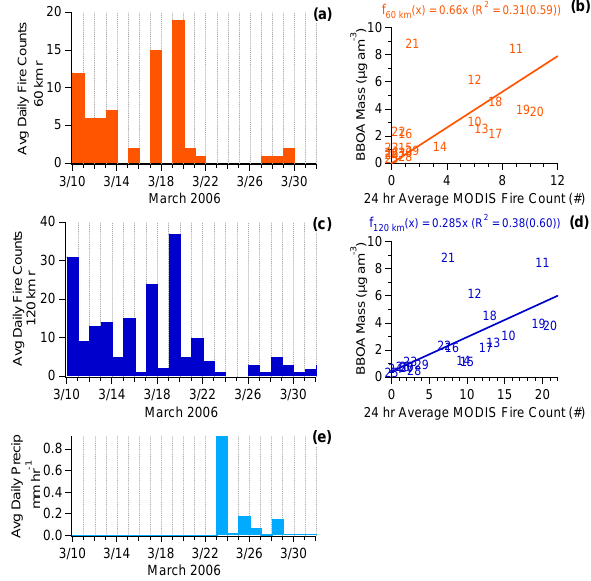
Figure 1. MODIS fire counts over 24-hr intervals for circles centered at T0 with two different radii, 60 km and 120 km, (a,c) during the sampling period and (b,d) plotted against the daily BBOA mass average. In (b and d), datapoint symbols indicate the day of the month in March, and the average of the fire counts is a 24-hr average from that day plus the previous day counts. Here and in all subsequent figures, the longer tick marks on the X-axis and a date label correspond to midnight local time.